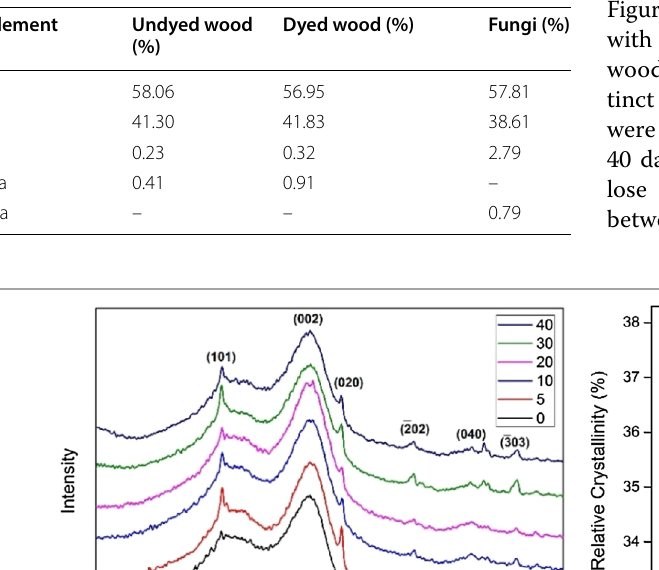
Table 1 EDS analysis of undyed wood, dyed wood at 40 days and fungi